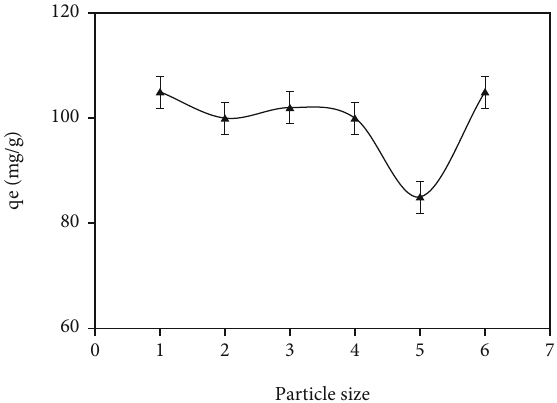
Figure 9: Graph of particle size e ff ect on CV (adsorbent dose: 0.05gL -1 ; room temperature; and contact time: